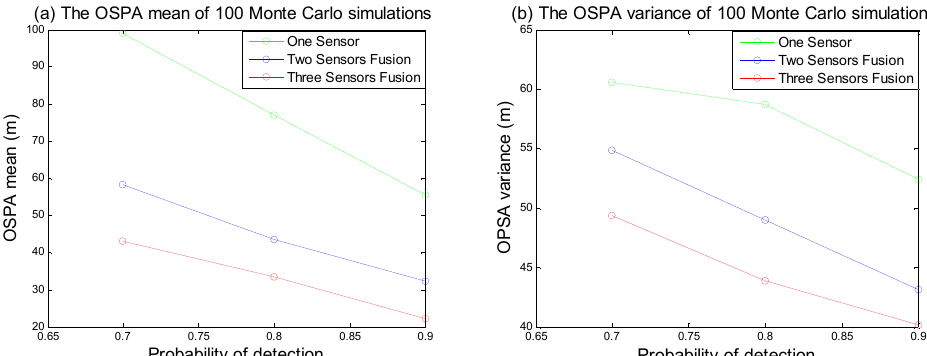
Figure 9. The OSPA statistical nature of Monte Carlo simulations. ( a ) is the OSPA mean of 100 times Monte Carlo simulations; ( b ) is the OSPA variance of 100 times Monte Carlo simulations.